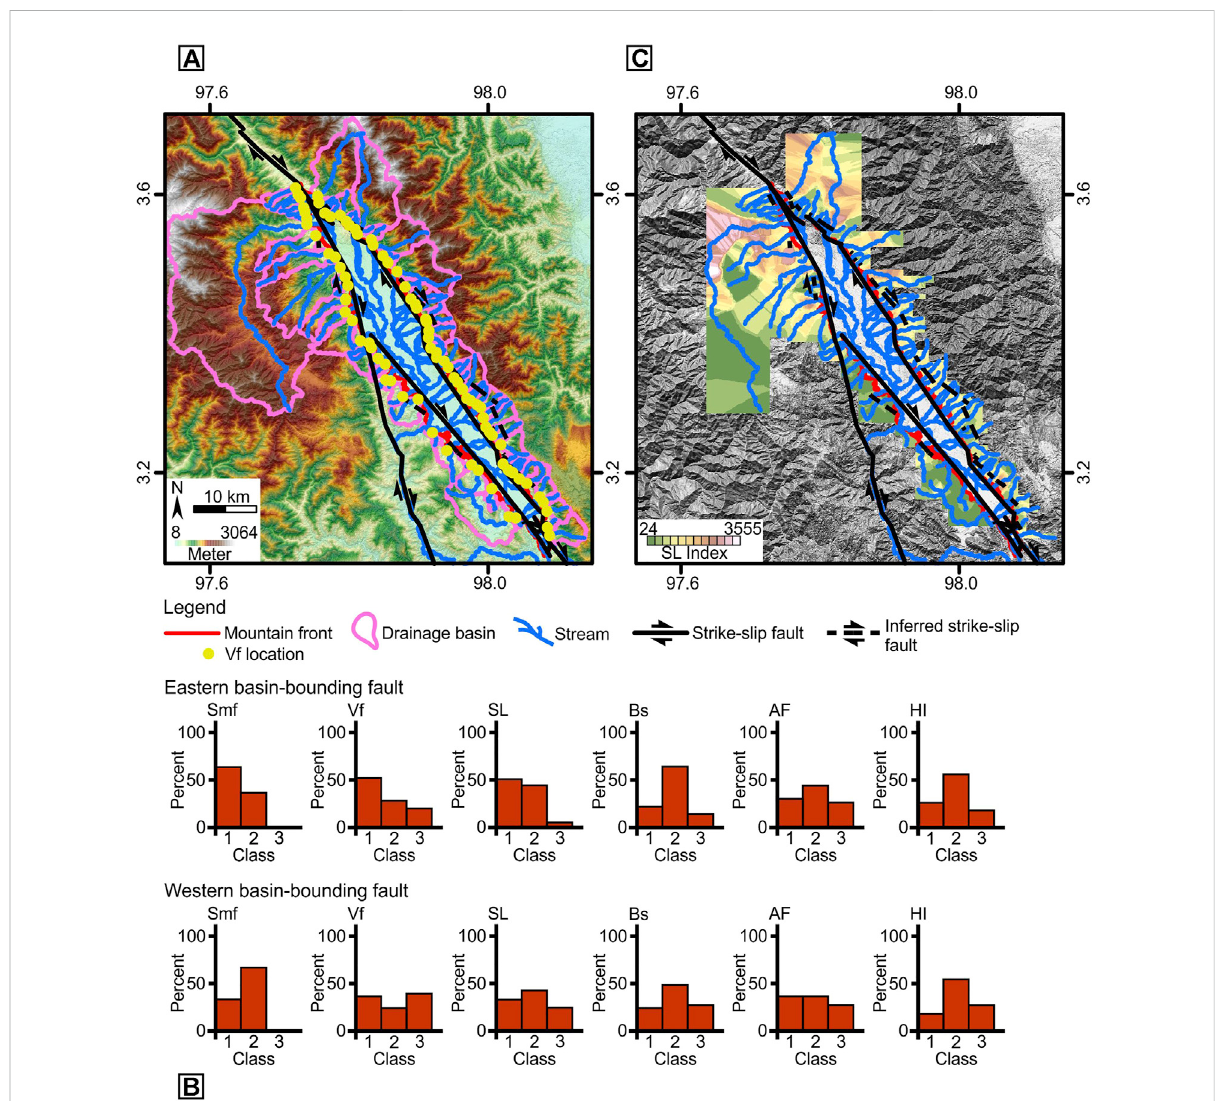
FIGURE 12 The Kutacane Basin: (A) the mountain fronts, faults, and drainage basins, (B) classi fi cation of geomorphic indices, and (C) stream length- gradient map.